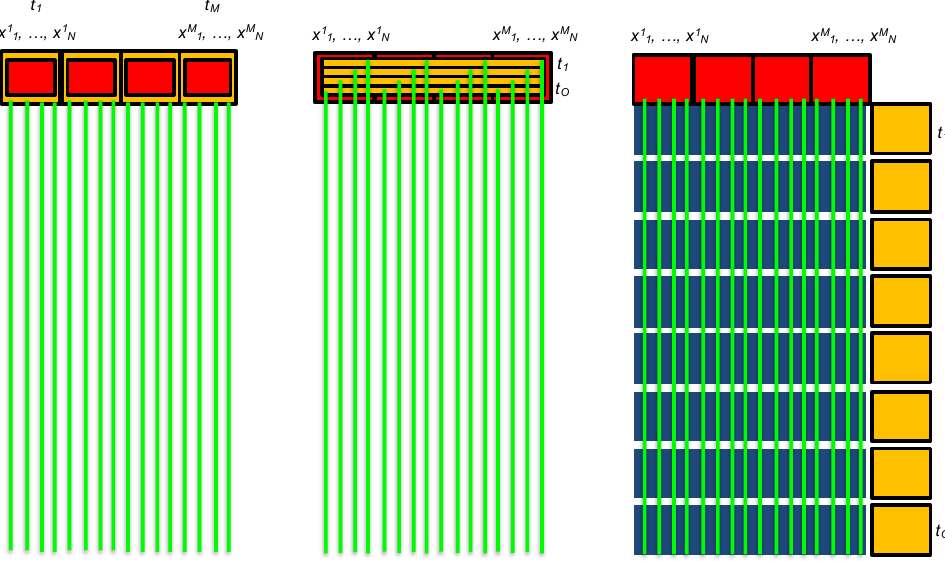
Figure 5. Conceptual sketch of three possibile arrangements of the position/charge (in red) and timing (with “grouping“, in yellow) readout channels. ( Left ): the same strips are read for both position/charge and timing measurements. The readout FEE provides a single position/charge measurement per strip and a single time measurement per group ( N strips). This approach can be applied for any LGAD technology but requires a single FEE ASIC for both position/charge and time measurements. ( Center ): same as left, but the timing readout FEE i th channel reads out the parallel output of all i th strips for each group of N . This can be obtained with a double-side (e.g., in iLGAD technology) or multi-layer (e.g., in AC-LGAD technology) processing of the sensor or a custom, tailored, FEE ASICs. ( Right ): the strips for the position/charge and those for the timing measurement are orthogonal. This requires a double-side or multi-layer LGAD technology, but separate, FEE ASICs. Strips with larger width/pitch on the “timing” side are used to decrease the number of timing readout